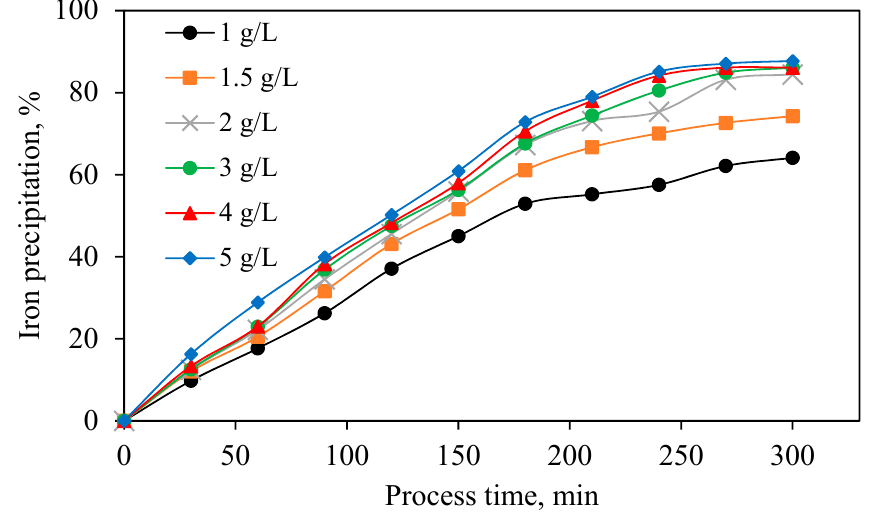
Figure 7. Effect of Na 2 SO 4 concentration on iron precipitation (Constant pH = 1, Temperature = 90 °C, Stirring speed = 600 RPM).